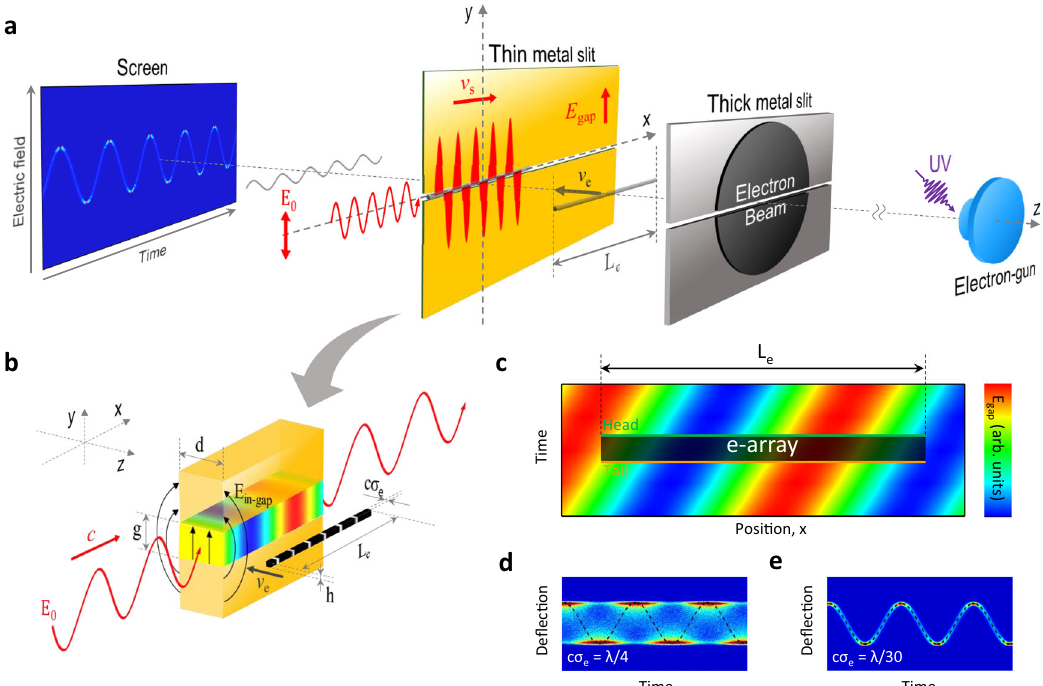
Fig. 1 Conceptual illustration of the real-time ultrafast oscilloscope. a Schematic setup for the real-time measurement of an unknown optical signal by using a MeV electron bunch. The ultrashort electron bunch is generated from a UV-induced electron gun, and its velocity ( v e ) is close to the speed of light. The input optical signal with linear electric polarization is coupled laterally into the gap of a thin metal slit and propagates along the gap. The Q-1D electron array is de fl ected by the ampli fi ed electric fi eld inside the metal gap and then recorded on the screen. Here, the time window for single-shot acquisition depends only on the horizontal width ( L e ) of the electron beam. b Magni fi ed illustration of the orthogonal interaction between the optical signal and Q-1D electron array with a longitudinal length c σ e and a horizontal width L e , where c is the speed of light and σ e is the electron bunch duration. c Electric fi eld mapping inside the gap depending on the time and x -position. The black rectangle depicts the y -projection of the Q-1D electron array in ( b ). Green and orange solid lines indicate the fi rst and last rows of the Q-1D electron array. d , e Superimposition effect of waveforms depending on the relationship ¼ λ = 4 ( d ) and c σ ¼ λ = 30 ( e between σ e and λ calculated for intuitive comparison of two extreme conditions: c σ e e